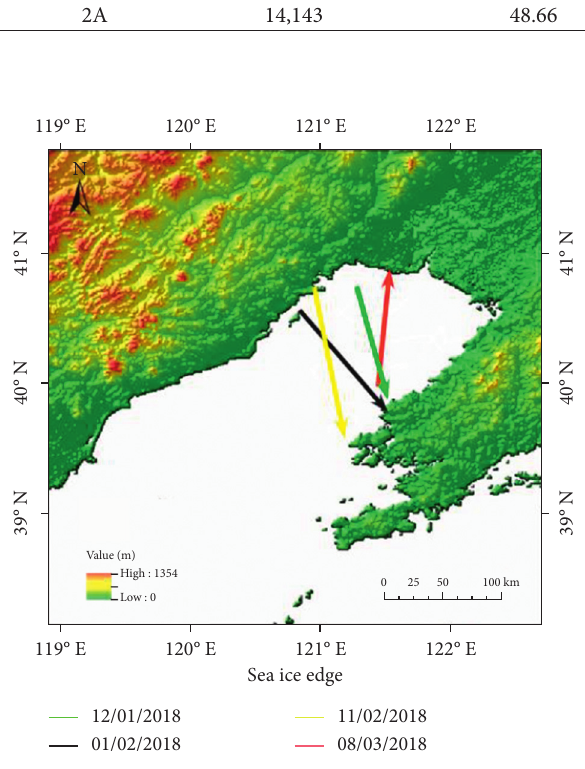
Figure 2: Topographic map of study area.